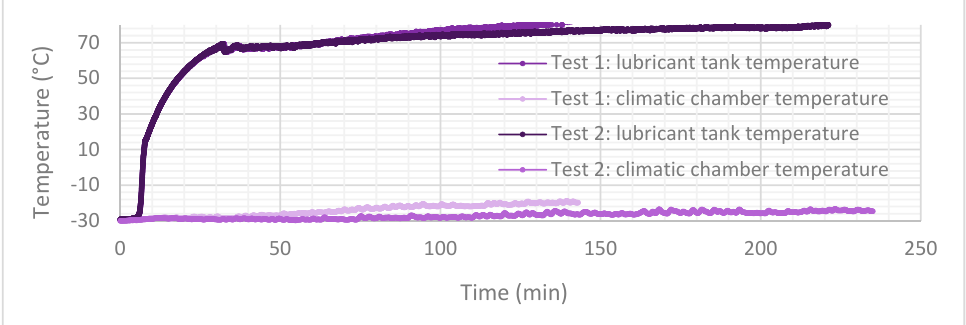
Figure A4. Lubricant tank and climatic chamber temperature trend at a thermostatic temperature of − 30 °C during the two repetitions. During one of the repetitions, the thermostatic temperature was not steady.